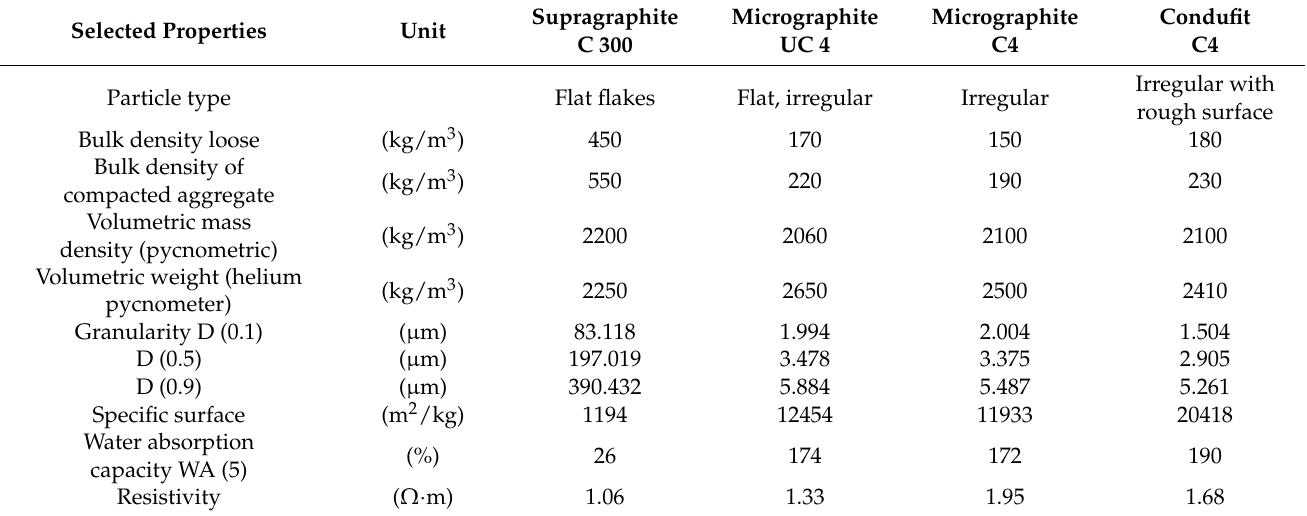
Table 5. Selected properties of used graphite types.